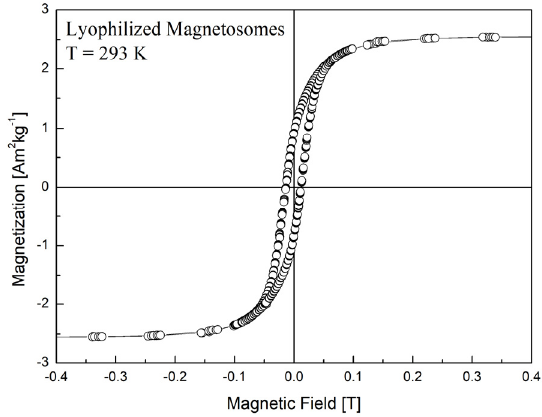
Figure 2. Magnetization curve of isolated magnetosomes in the powder form.